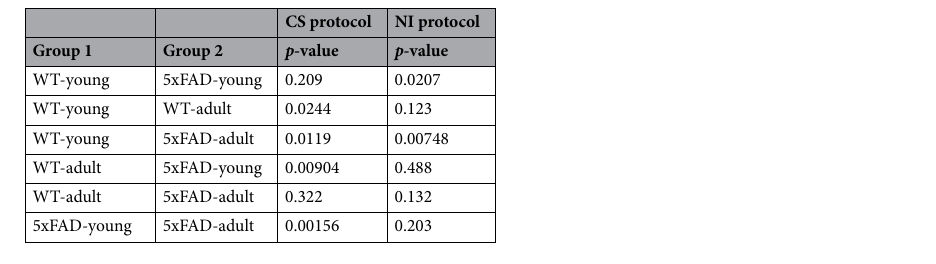
Table 2. Statistical comparison of the complexity index of the four groups. ✝ Mann–Whitney U